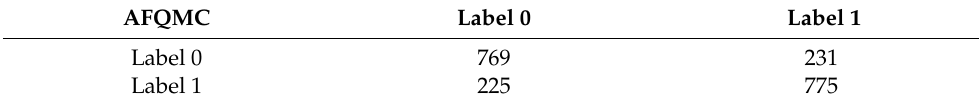
Table A1. Model performance. Confusion metric on AFQMCM.